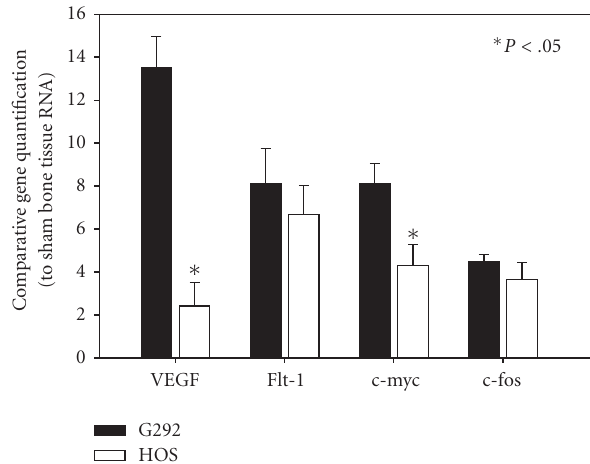
Figure 4: Comparative gene expression quantification using sham operated bone tissue as controls. Data expressed as the relative ex- pressions over those from sham bone tissu( ∗ P < .